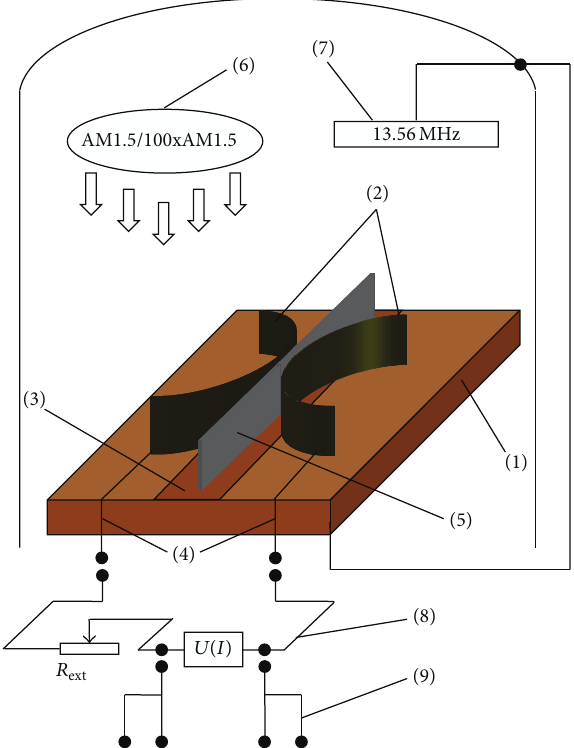
Figure 1: Schematic view of the holder and the setup for treatments and measurements: (1)—base; (2)—beryllium-copper springs; (3)— isolator template; (4)—Ag contacts for measurement of 𝐼 - 𝑈 char- acteristics; (5)—a single SC with VA p-n junction; (6)—imitators of solar irradiation; (7)—upper electrode for vacuum PECVD method; (8)—loaded 𝐼 - 𝑈 setup; and (9)—compensating 𝐼 - 𝑈 setup.